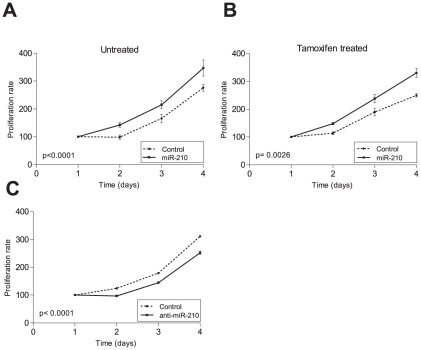
Involvement of miR-210 in cell proliferation.Cell growth curves for MCF7-miR-210 and MCF7-control in untreated (A) and Tamoxifen-treated (10−7 M) conditions (B). Cell growth curves for MDA-MB-231-anti-miR-210 and MDA-MB-231-control (C).